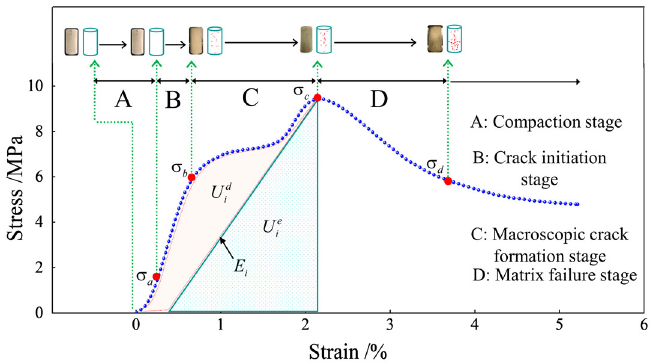
Figure 13. Evolution process of specimen failure energy.